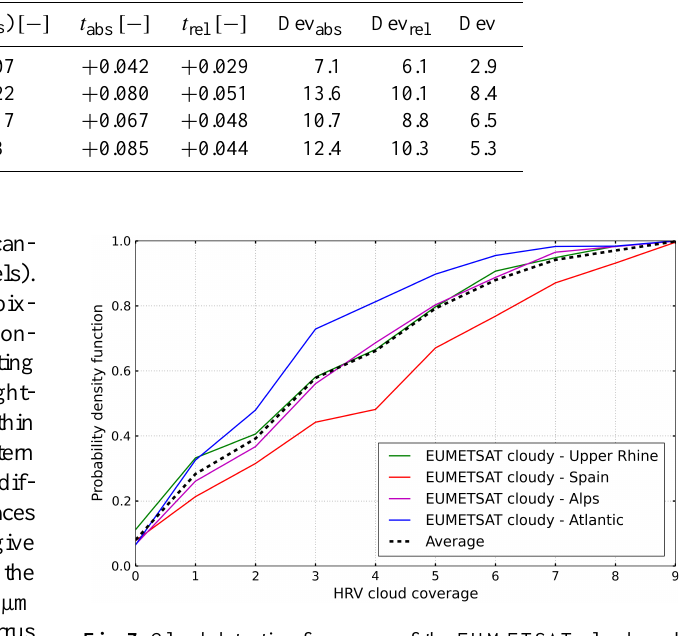
Fig. 7. Cloud detection frequency of the EUMETSAT cloud mask versus the number of cloudy HRV pixels detected by the HRV cloud mask for a corresponding 3 × 3 HRV pixel block. The solid colored lines mark the average obtained for all HRV pixel blocks for the four regions between 1 June 2011 and 16 August 2011. The average over all regions is indicated by the dotted line.